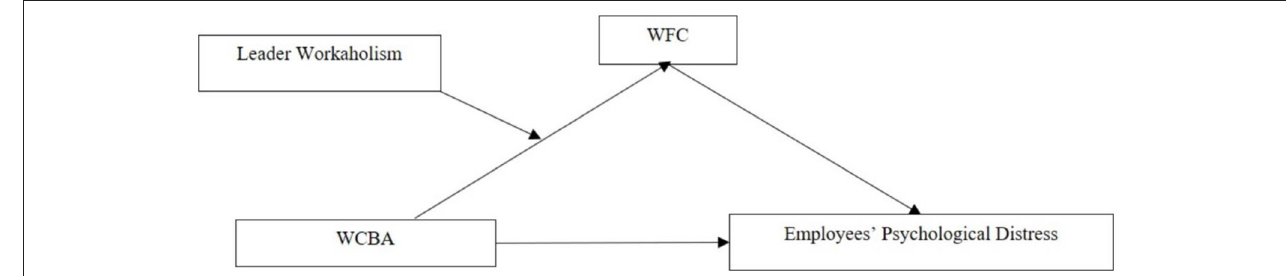
FIGURE 1 | Research theoretical